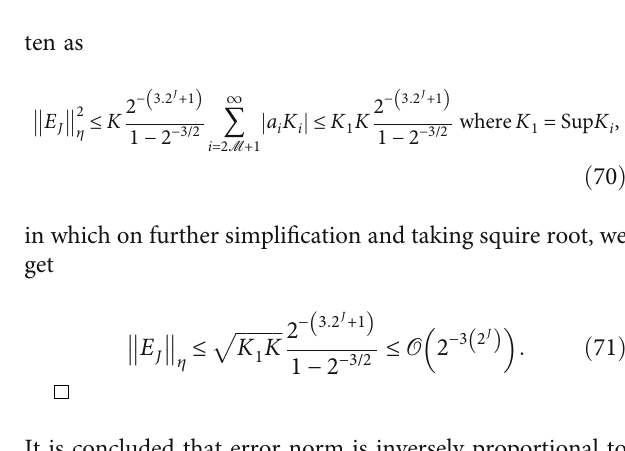
Figure 1: The stability analysis of the proposed method for di ff erent examples at N = 64 , Δ t = 0 : 01/32 , t = 1 , a = 0 , and b = 1